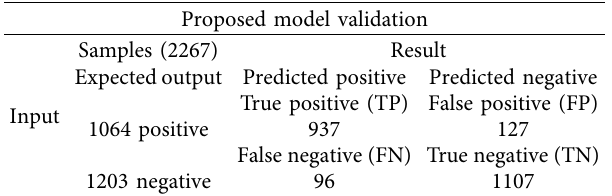
Table 4: Proposed model validation during the prediction of 5G congestion (Na¨ıve